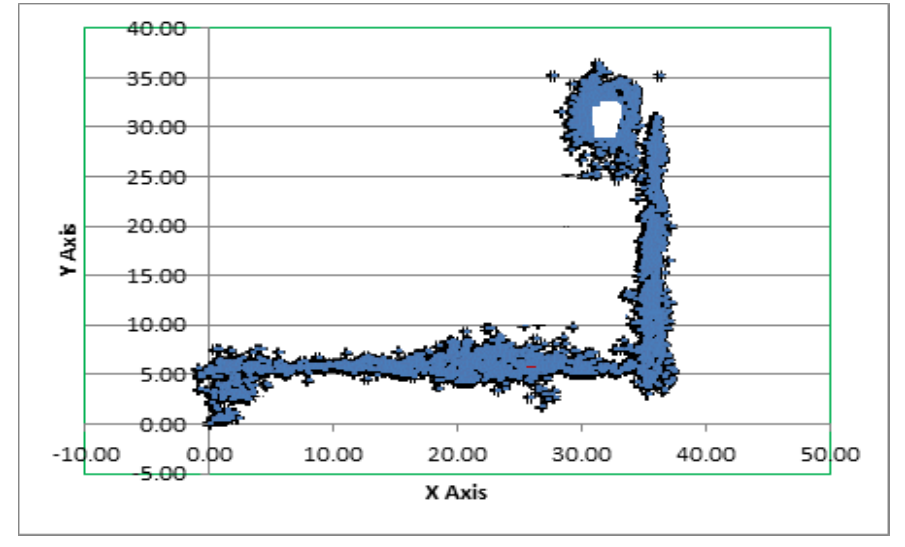
Figure 14. Predicted ( x ’, y ’) position based on the deep MLP model.